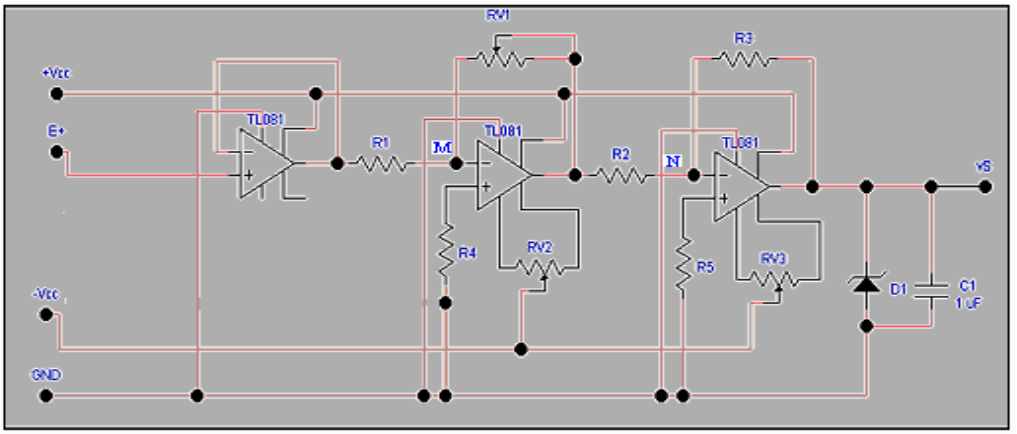
Figure 12. The solar cell device